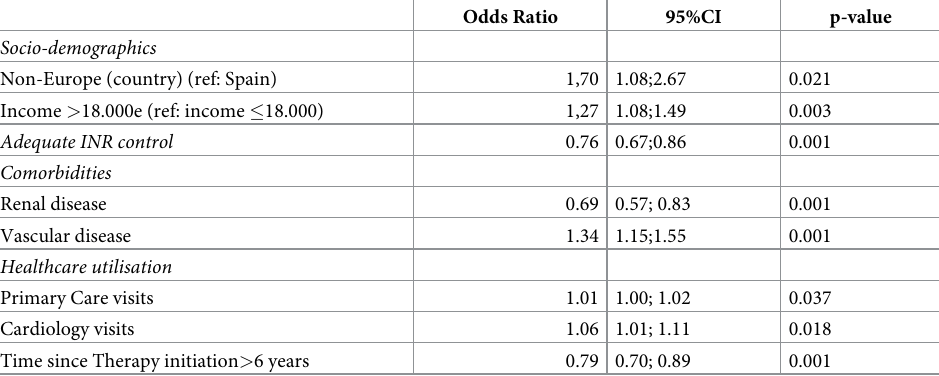
Table 4. Factors associated with switching to